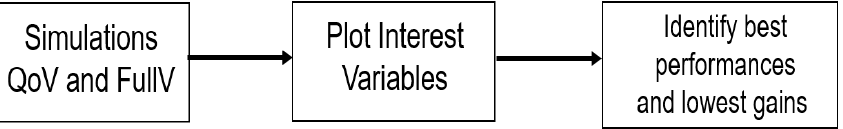
Figure 12. Simulation and analysis process.